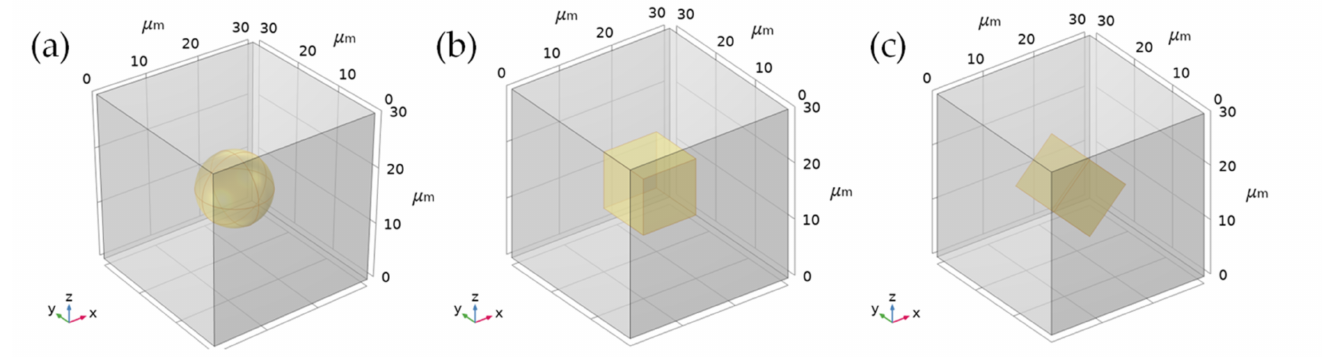
Figure 11. The geometric model of a composite material filled with a single particle. ( a ) A single spherical particle; ( b ) A single cubic particle placed horizontally; ( c ) A single cubic particle rotated 45 ◦ .